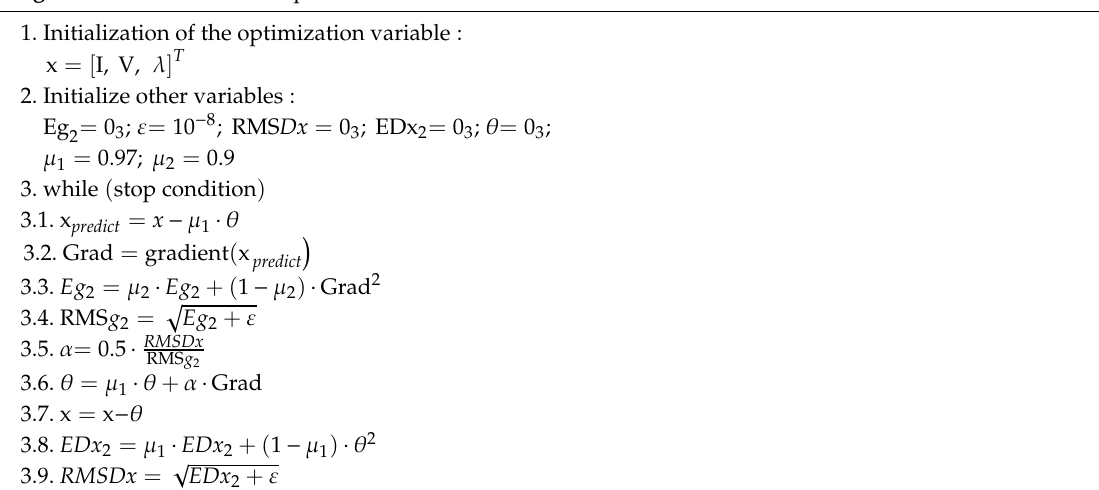
Algorithm 1. Out forward Optimisation for